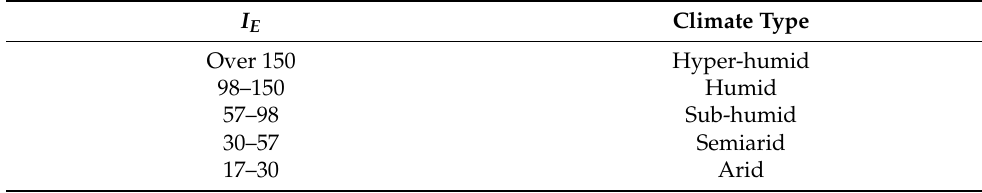
Table A1. Climate classes of Emberger [51]